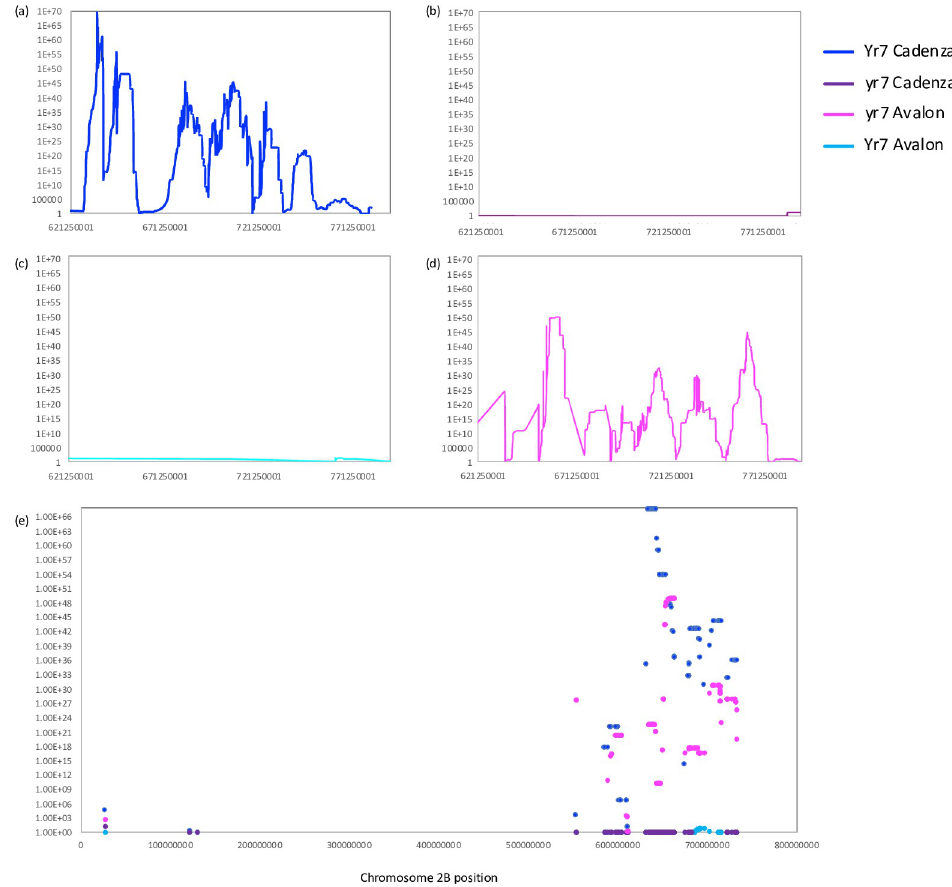
Fig 5. Homozygosity scores calculated for the Yr7 and yr7 bulked datasets along chromosome 2B. Scores calculated per 10,000,000bp window along chromosome 2B at 10,000bp intervals. (a) Scores plotted for ‘Cadenza unique homozygote alleles’ found in the Yr7 bulk segregated dataset. (b) Scores plotted for ‘Cadenza unique homozygote alleles’ found in the yr7 bulk segregated dataset. (c) Scores plotted for ‘Avalon unique homozygote alleles’ found in the Yr7 bulk segregated dataset. (d) Scores plotted for ‘Avalon unique homozygote alleles’ found in the y r7 bulk segregated dataset. (e) Scores reported here only for windows on chromosome 2B containing the iSelect SNPs that could be mapped to pseudo-chromosome 2B. If multiple windows hit the iSelect SNP, the average score across the windows was calculated. Scores plotted for all datasets (a-d) i.e. Yr7 / yr7 Avalon and Cadenza specific homozygote scores and datapoints coloured according to the